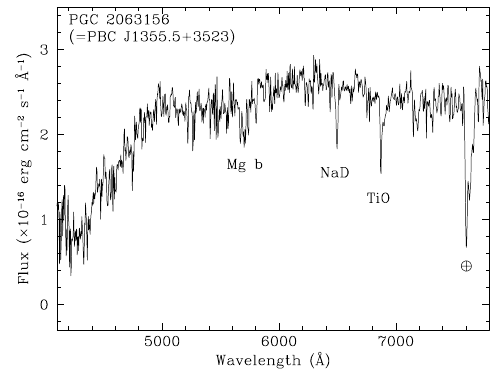
Figure 7: Optical spectrum (not corrected for the in- tervening Galactic absorption) of a typical XBONG. The main spectral features are